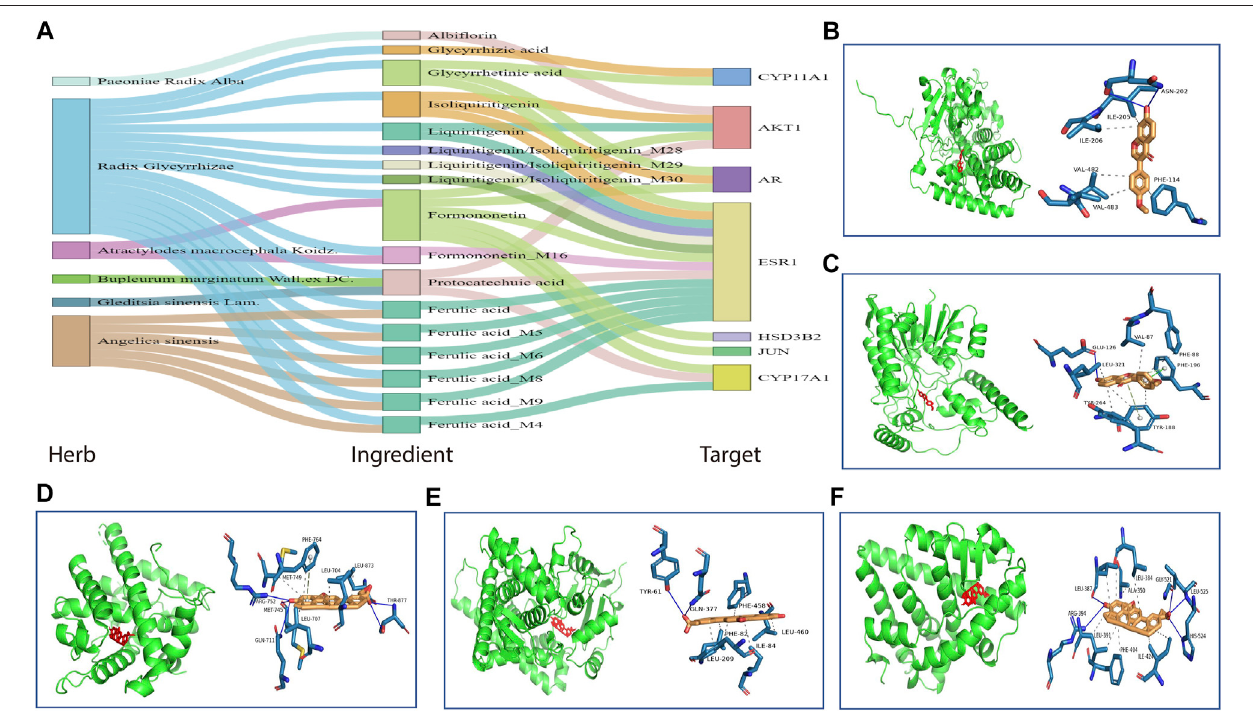
FIGURE 8 | The keysubstances for HHXYT toexerttherapeutic effects on MGH. (A) Herb-ingredient-target relationships for key targets, herbs, and ingredients of HHXYT. The integrated name of prototypes and their metabolite ID means thatthe metabolite isderived from the correspondingprototypes. (B – F) Molecular docking of HHXYT ’ s fi ve key targets with corresponding compounds. The binding poses and binding sites of formononetin complexed with CYP17A1 (B) and HSD3B2 (C) ; The binding poses and binding sites of glycyrrhetinic acid complexed with AR (D) , CYP11A1 (E) , and ER (F) .